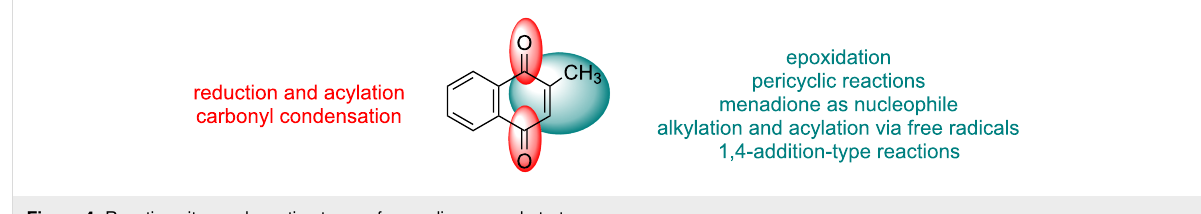
Figure 4: Reaction sites and reaction types of menadione as substrate.